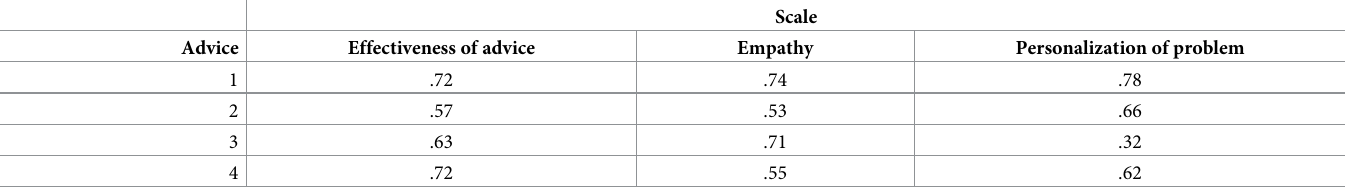
Table 2. Interrater reliability of the coders’ evaluations of the pieces of advice—linearly weighted kappa (the interpersonal problem-solving study).